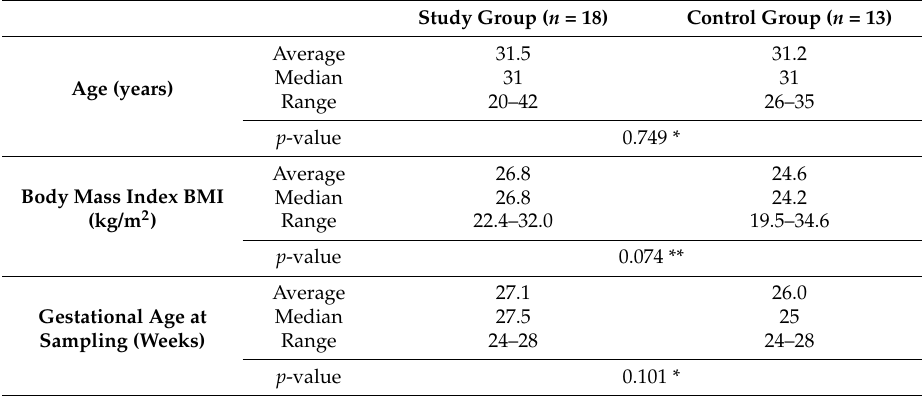
Table 1. Characteristics of the study group (GDM patients) and control group (normal pregnancy women). The references indicate the distribution shape of the appropriate variable and univariate statistical test, which was used for comparison of the variable between two groups depending on the distribution shape: * Not normal distribution, Mann–Whitney U test; ** Normal distribution, t